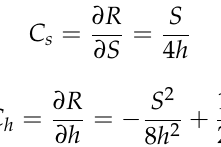
Table 8. The procedure budget about the uncertainty of arc AB.